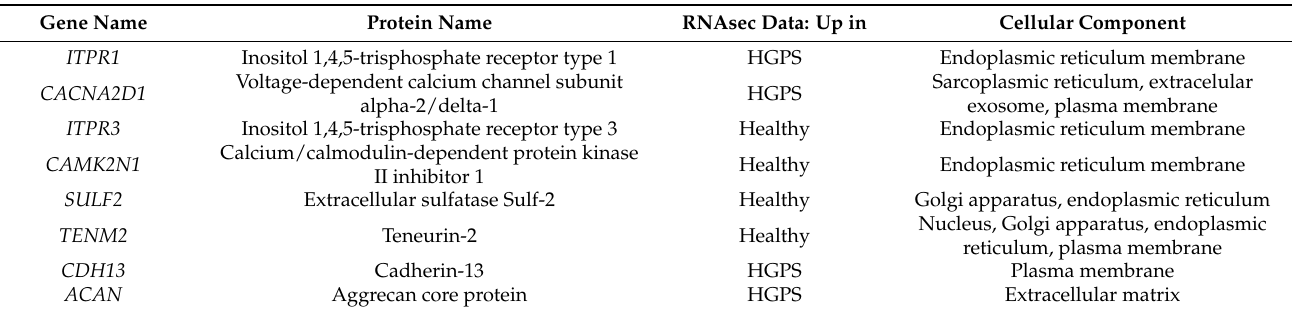
Table A1. Transcripts involved in Ca 2+ signaling.